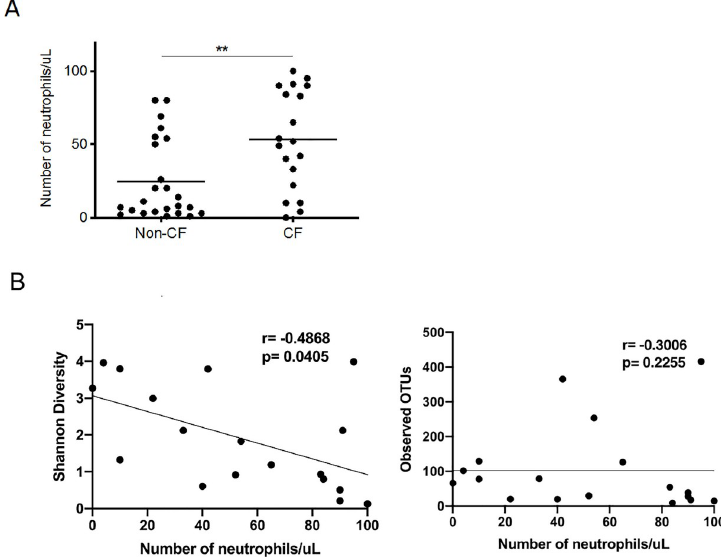
Fig 7. Lung microbiome diversity and inflammation in CF and non-CF controls. (A) Neutrophil counts in CF and non-CF controls. Neutrophil count in the BAL was used as a surrogate for lung inflammation, and is shown in the y- axis. �� P = 0.0054 (Mann-Whitney U Test). (B) Spearman Correlation between neutrophil counts and microbial diversity (left) or species richness (right) in the BAL. Shannon diversity and species richness are shown in the y-axis as a function of BAL neutrophil